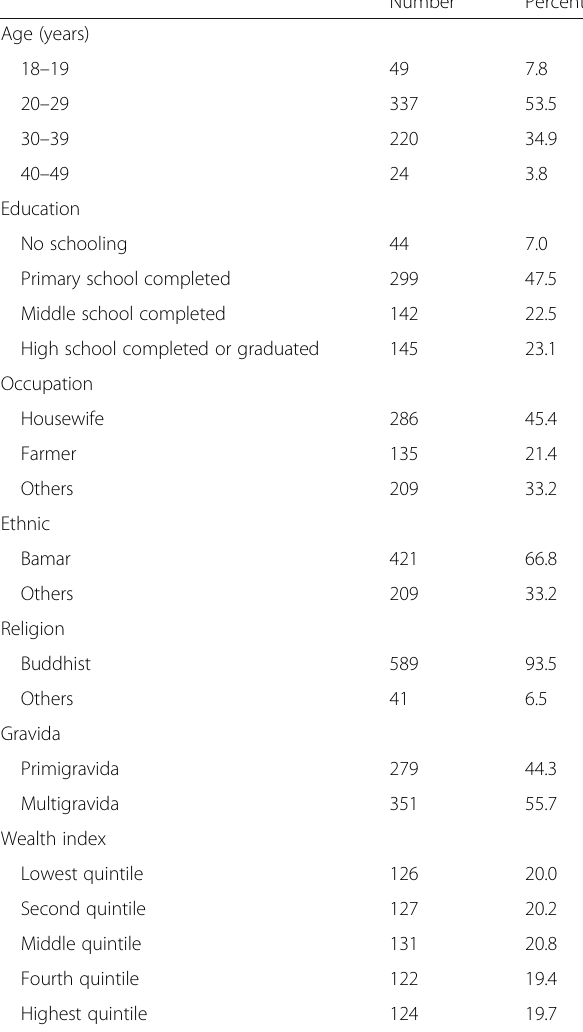
Table 1 Socio-economic characteristics of pregnant